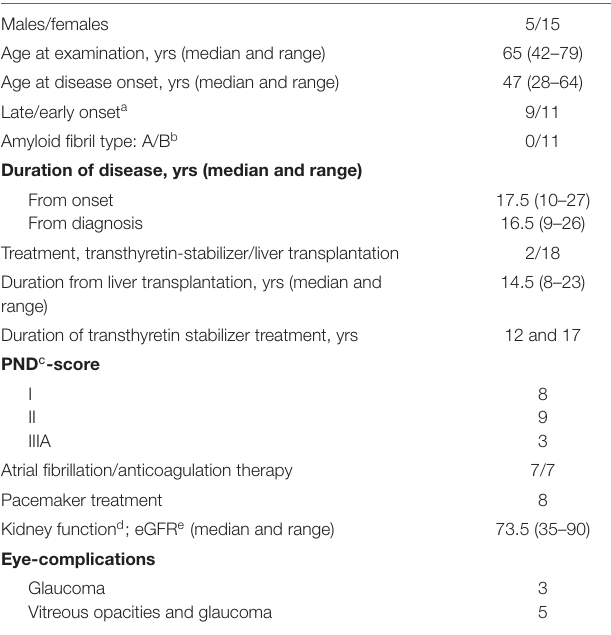
TABLE 1 | Clinical data of the 20 patients with hereditary transthyretin amyloid amyloidosis. Males/females Age at examination, yrs (median and